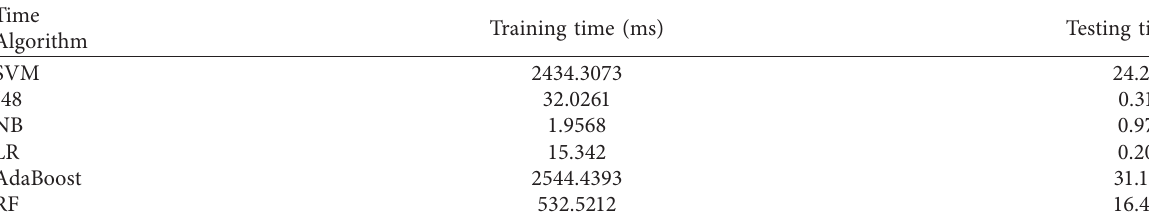
Table 6: Algorithm execution time